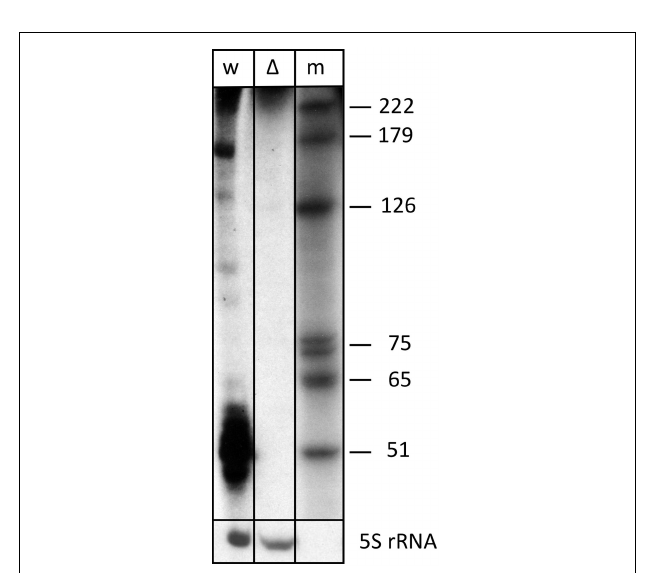
FIGURE 2 | The s479 precursor transcript is processed into a shorter RNA. Total RNA from wild-type (lane w) and (cid:49) s479 (lane (cid:49) ) cells was separated on a polyacrylamide gel. After transfer, the membrane was hybridized with a probe against s479 (upper panel, the lower panel was hybridized with a probe against the 5S rRNA). Lane w: RNA from H. volcanii wild-type strain, lane (cid:49) : RNA from a (cid:49) s479 strain, lane m: size marker; sizes are given at the right in